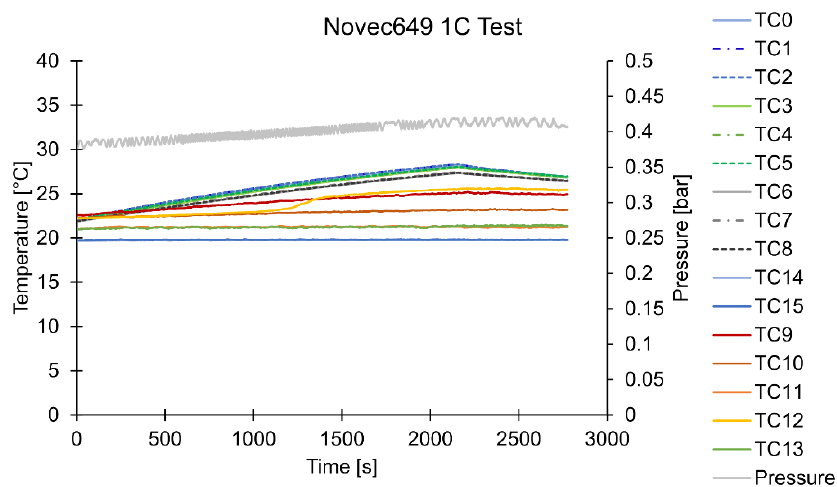
Figure 11. Fast Charging test results with 1C.